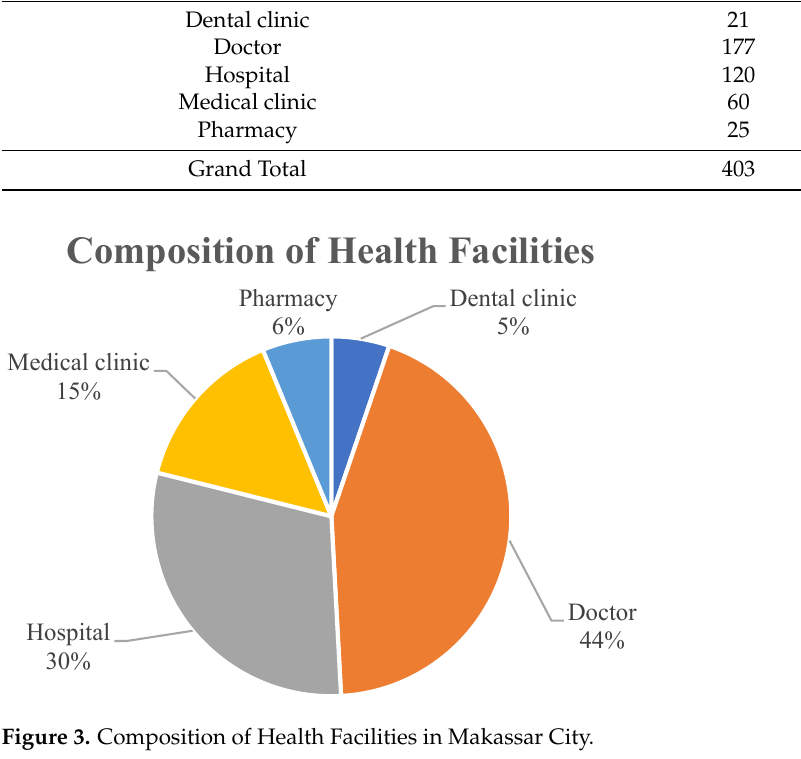
Figure 3. Composition of Health Facilities in Makassar City.